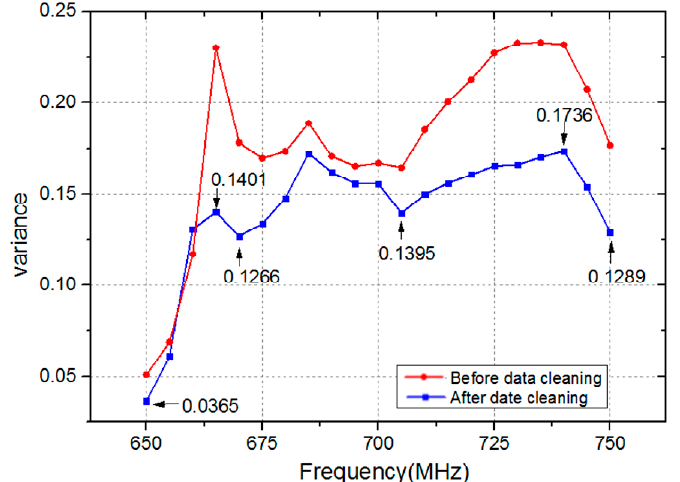
Figure 10. The variance of feature points after data cleaning.